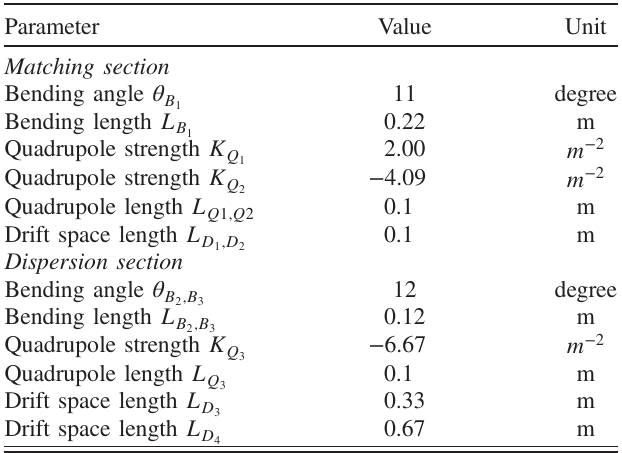
TABLE II. Main parameters of the beam optics in Fig. 1. Not labeled in the figure are drift sections D 1 between Q 1 and B 1 , D 2 between B 1 and Q 2 , D 3 between B 2 and Q 3 , and D 4 between Q 3 and B 3